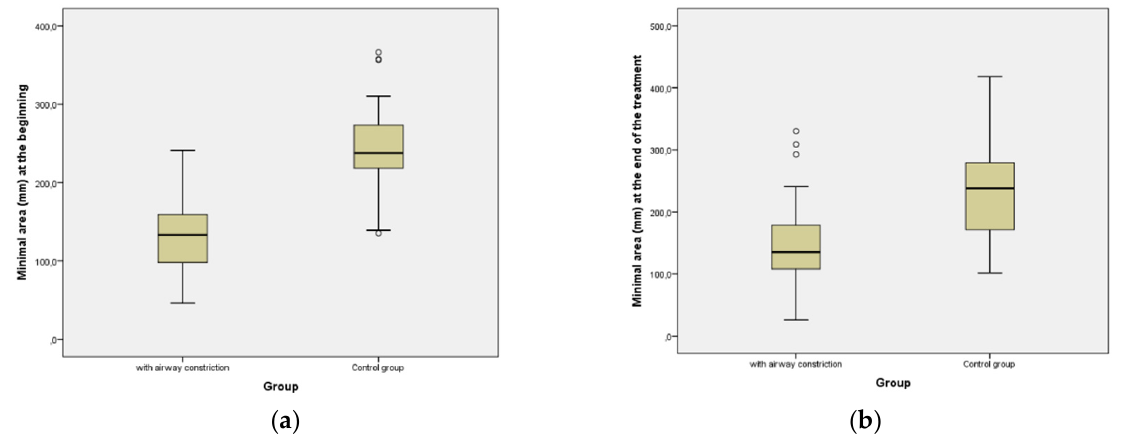
Figure 7. Comparison of volumetric changes of the airway before and after aligner treatment. ( a ) Pre-treatment; ( b ) post-treatment increase of airway volume in Group A and decrease in the control group. Asterisk (*) represents Extreme outlier which is an observation that lies an abnormal distance from other values. Extreme outliers are any data values which lie more than 3.0 times the interquartile range below the first quartile or above the third quartile. Circles (o) represent Common outliers. Before treatment, the mean value of the minimal cross-section airway was 130.28 mm 2 versus 146.97 mm 2 after treatment, as shown in Figure 8.